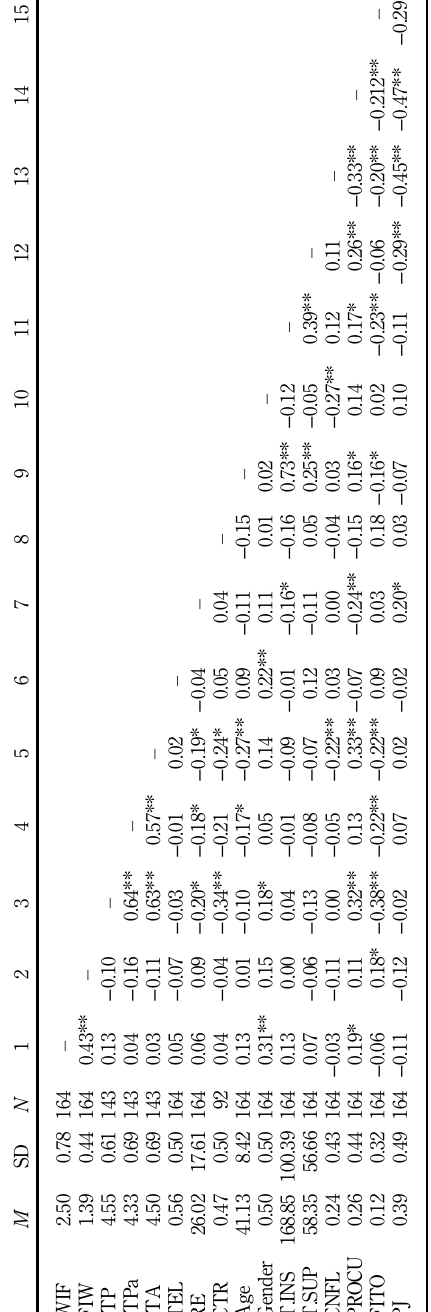
Table I. Means, standard deviations, total sample and